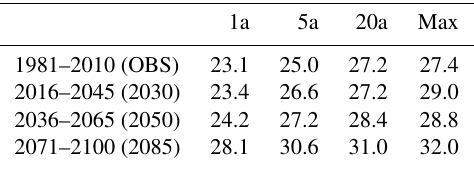
Table 1. Mean 5-day air temperatures of modelled future heat wave episodes used as selection criteria, shown with equivalent values from the observed period for